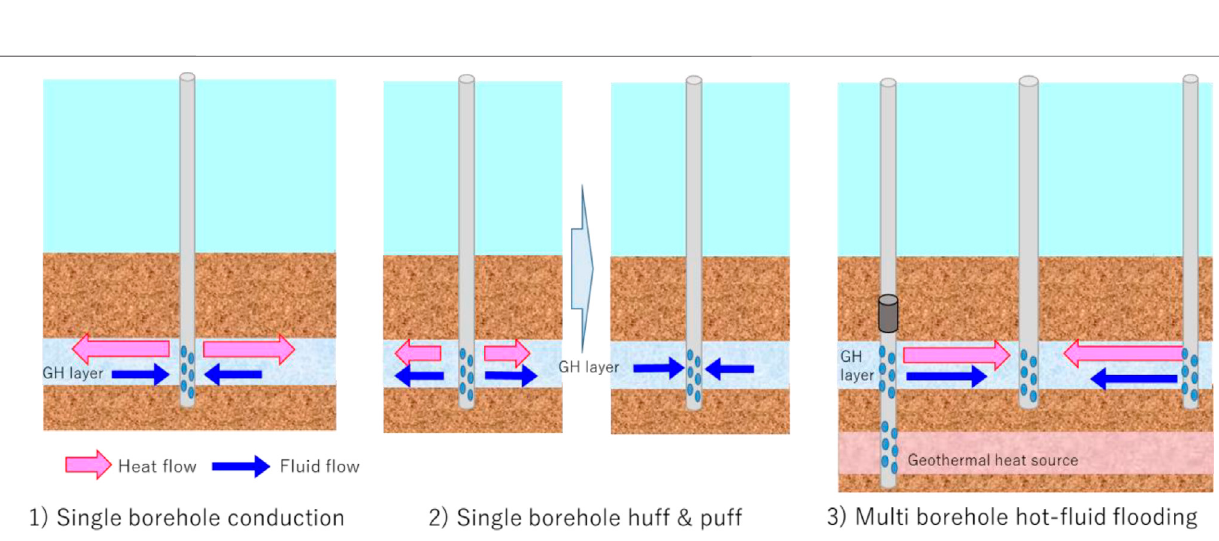
Frontiers in Energy Research |